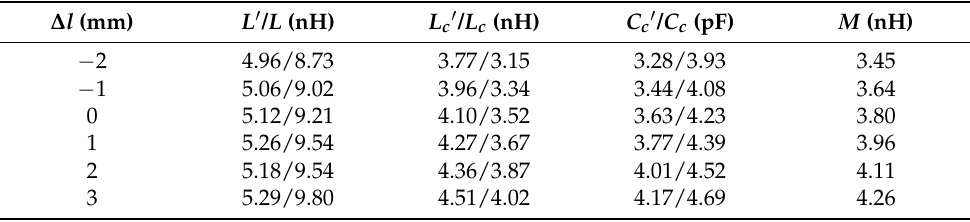
Table 1. Circuit parameters of the circuits of Figure 2 for different lengths of the narrow slot of the DB-DGS